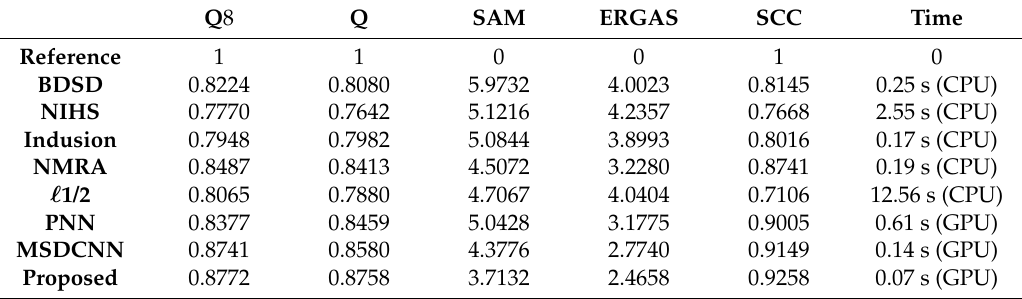
Table 1. Performance indicators of a WorldView-2 image at reduced scale.